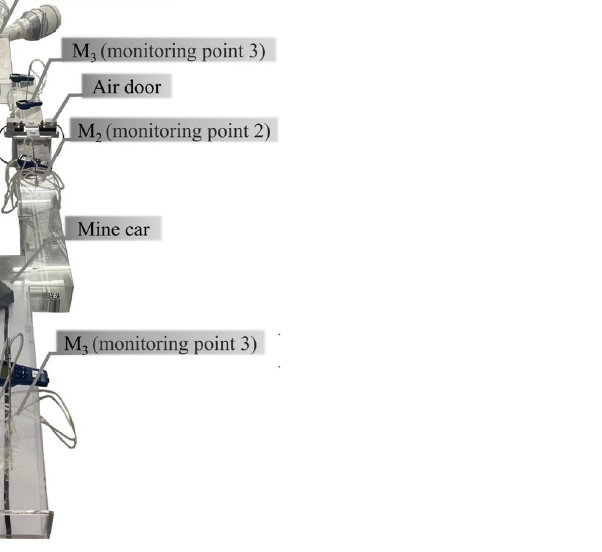
Fig 7. Overview of experimental